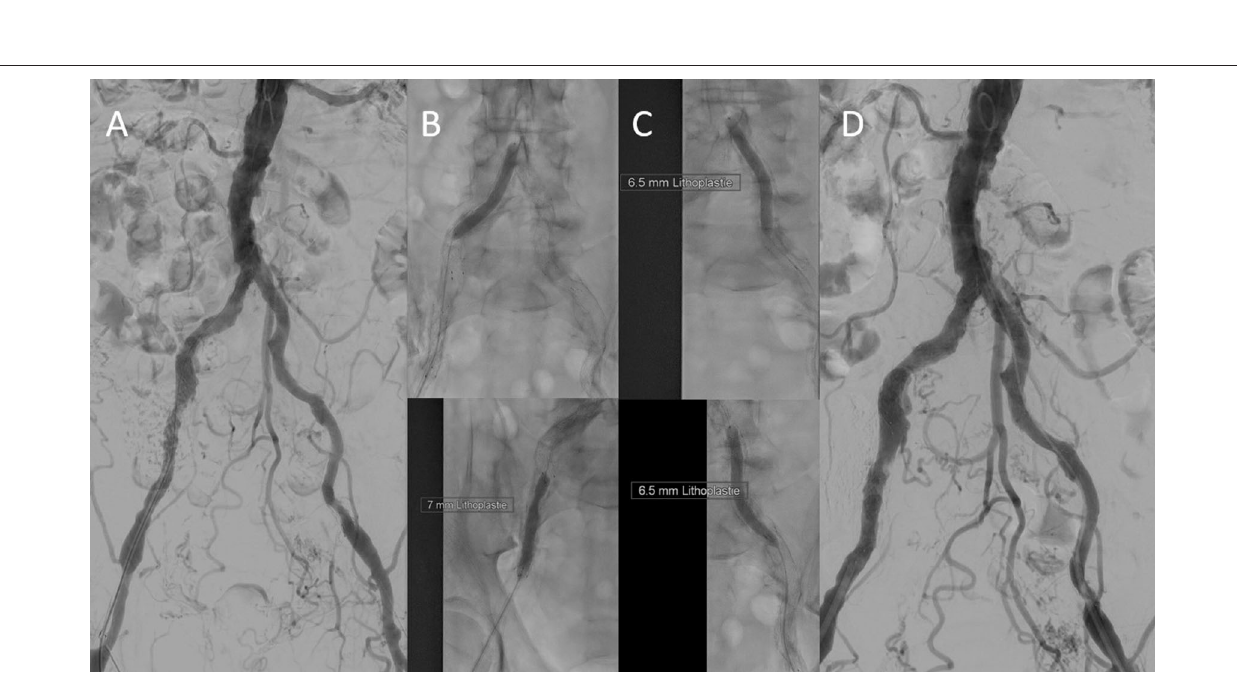
Frontiers in Cardiovascular Medicine |